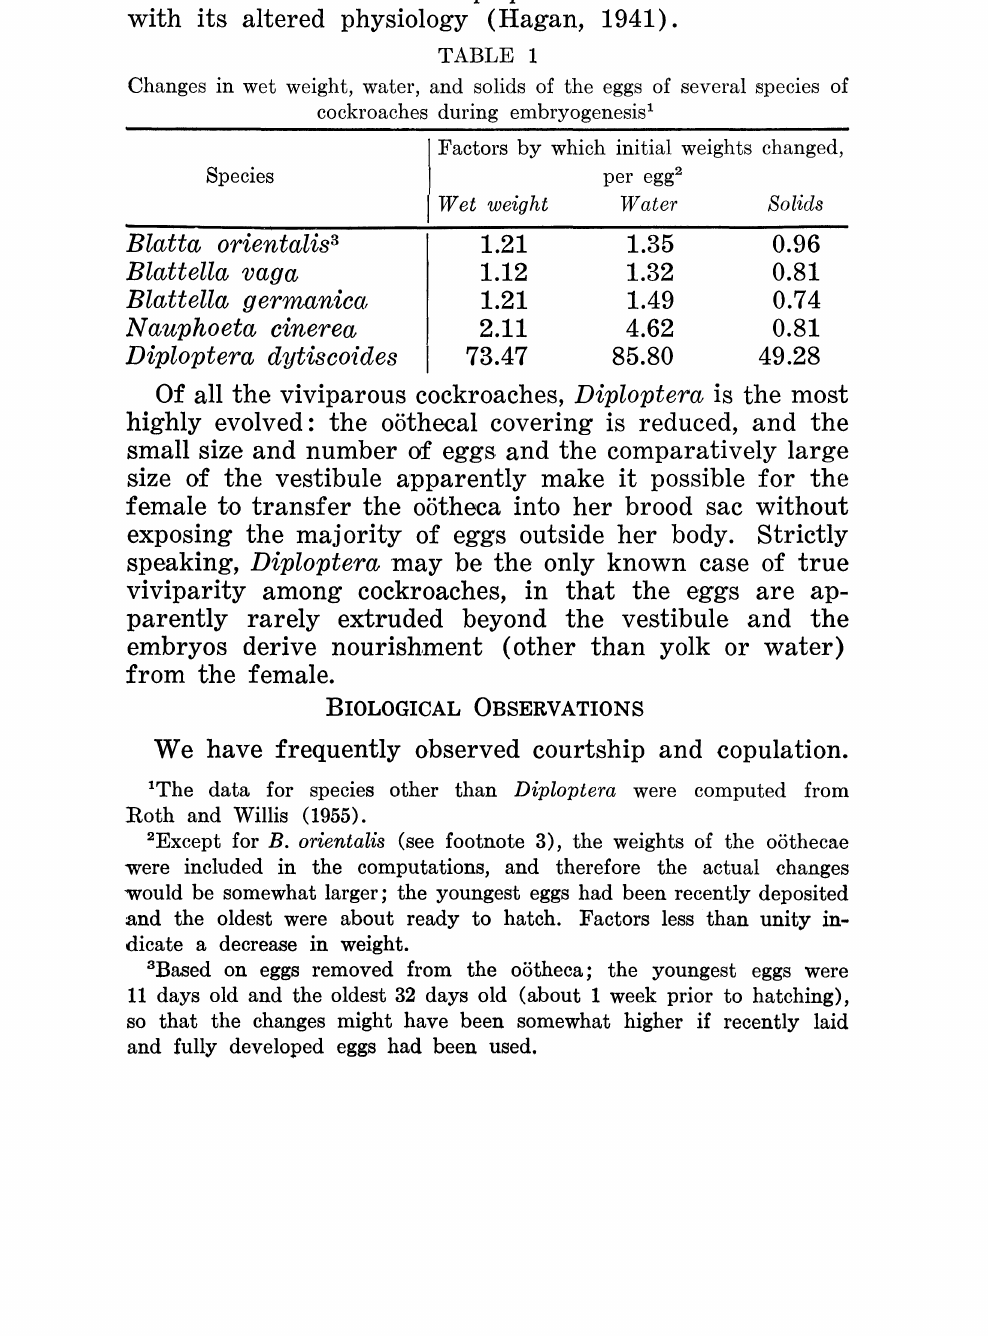
Changes in wet weight, water, and solids of the eggs of several species of cockroaches during